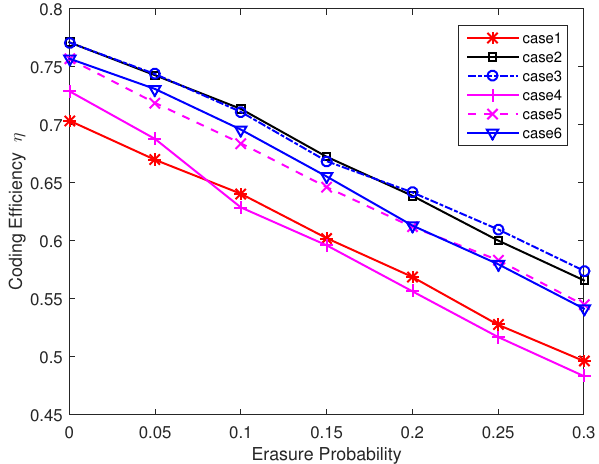
Figure 7. Coding efficiency η for different degree distribution (Two nodes).